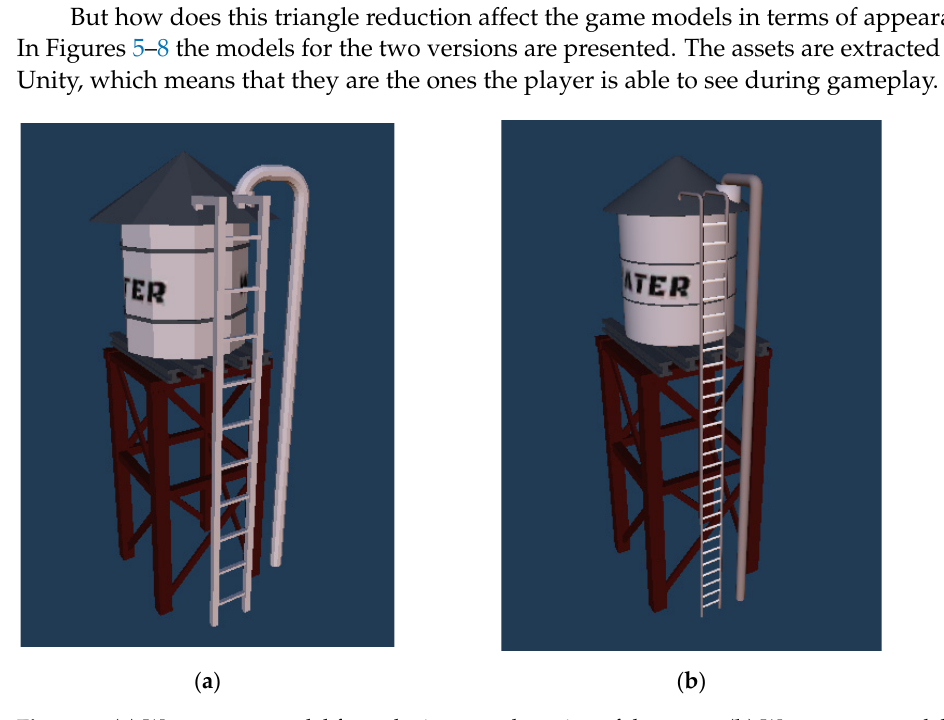
Figure 6. ( a ) Water tower model from the improved version of the game. ( b ) Water tower model from the non-improved version of the game.